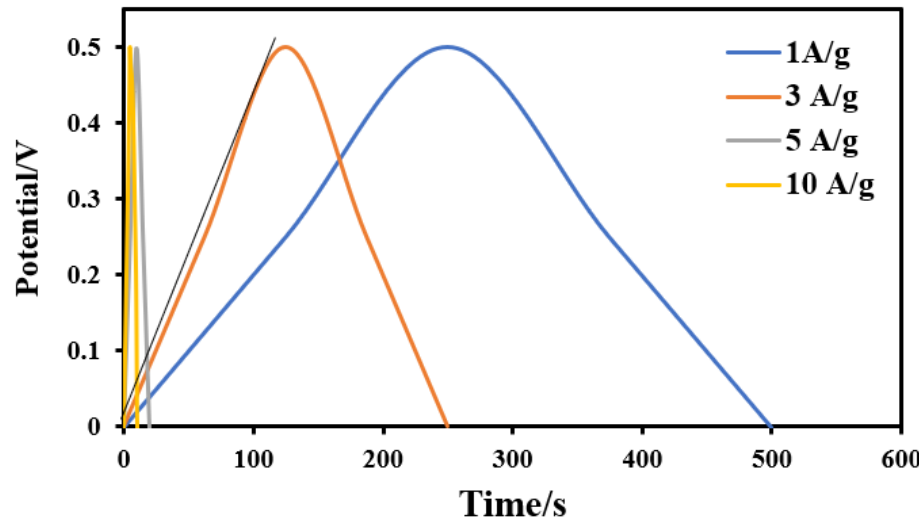
Figure 11. Galvanostatic charge/discharge curves for the activated carbon electrode obtained from activation by a combined H 3 PO 4 /KOH activation agent (14 mL) at current densities of 1, 3, 5 and 10 A/g.